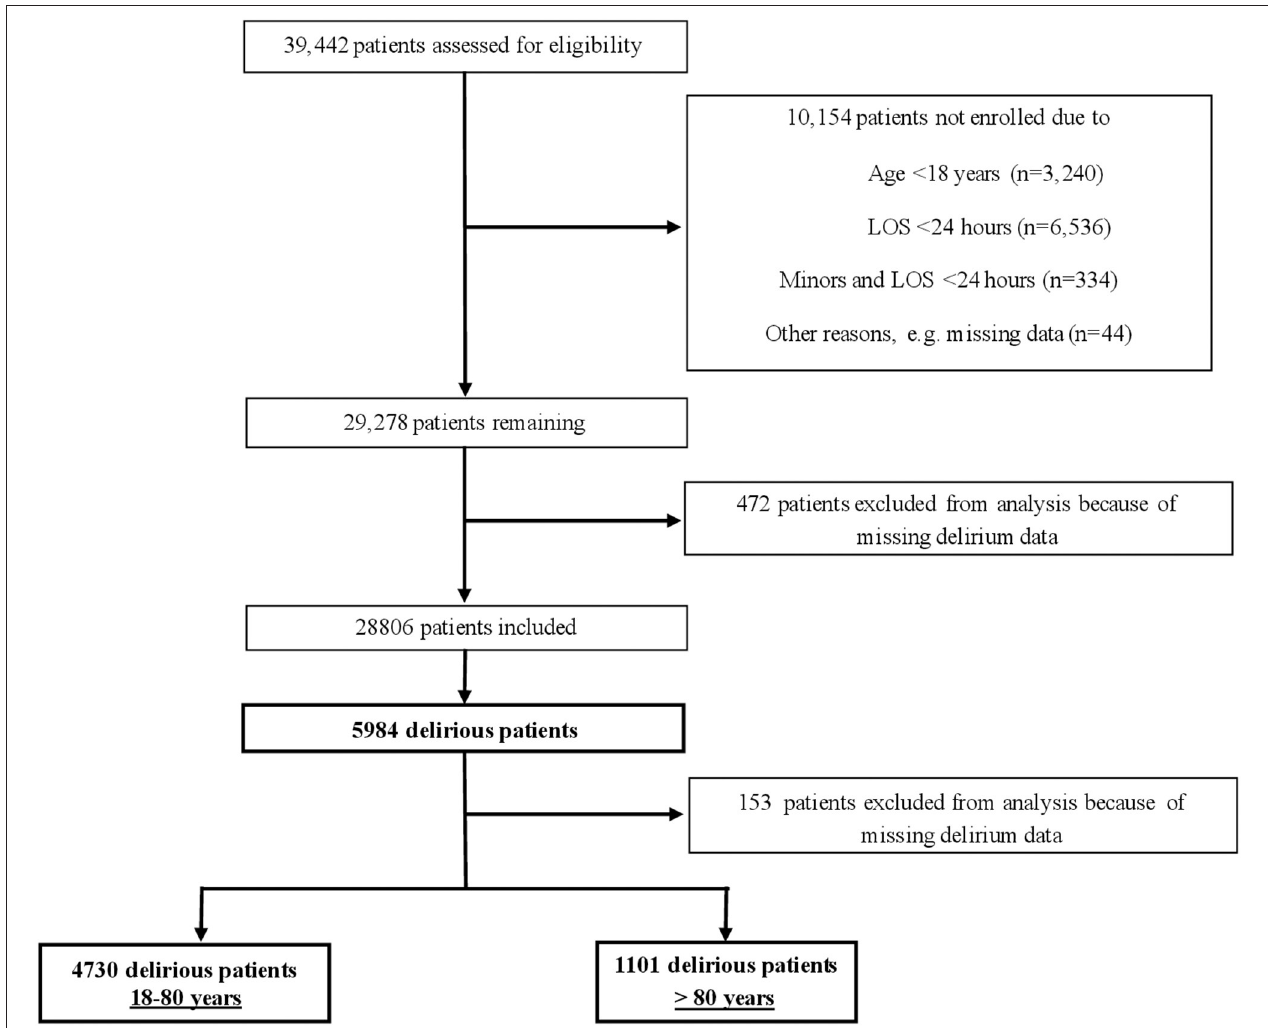
FIGURE 1 | Screening-algorithm of the Delir-Path .